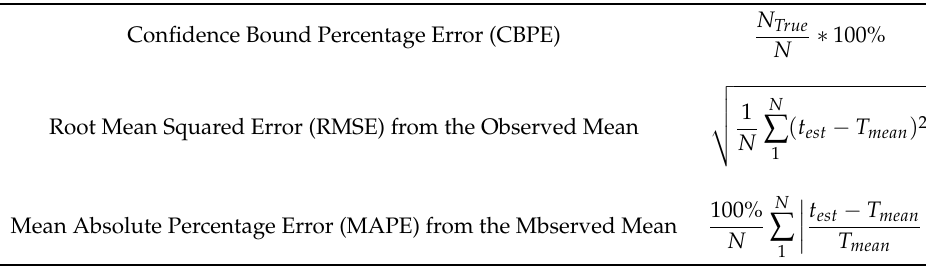
Table 1. Definitions of applied error